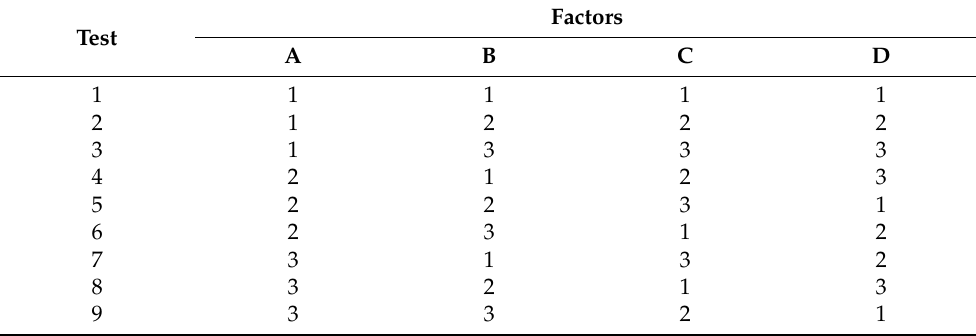
Table 1. Orthogonal arrange with four factors and three levels L 9 = (3) 4